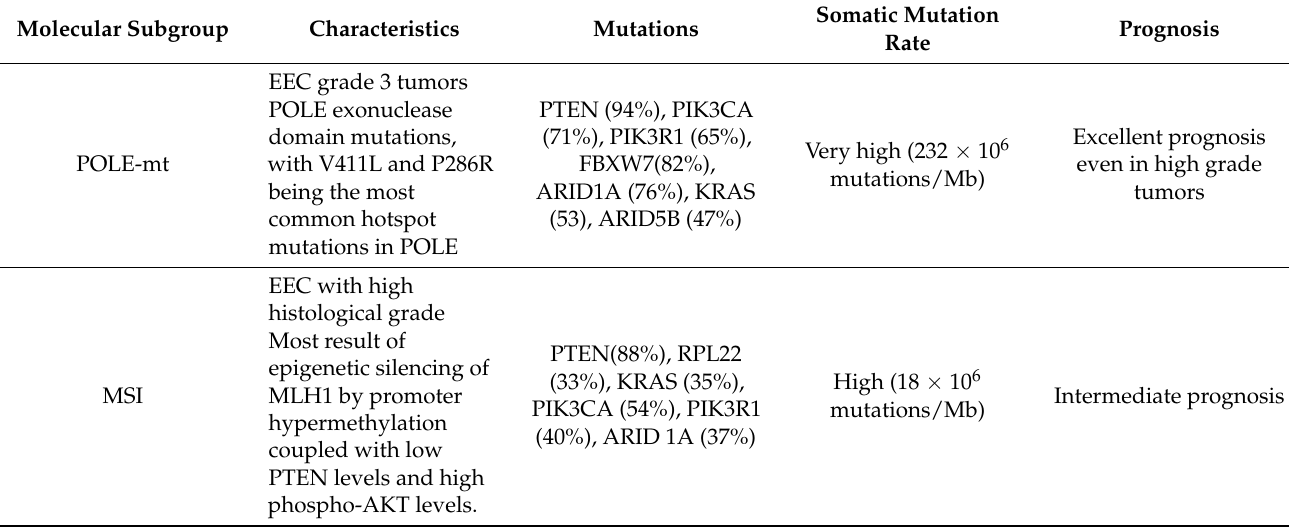
Table 2. Description of TCGA EC molecular subgroups and prognosis. Molecular Subgroup